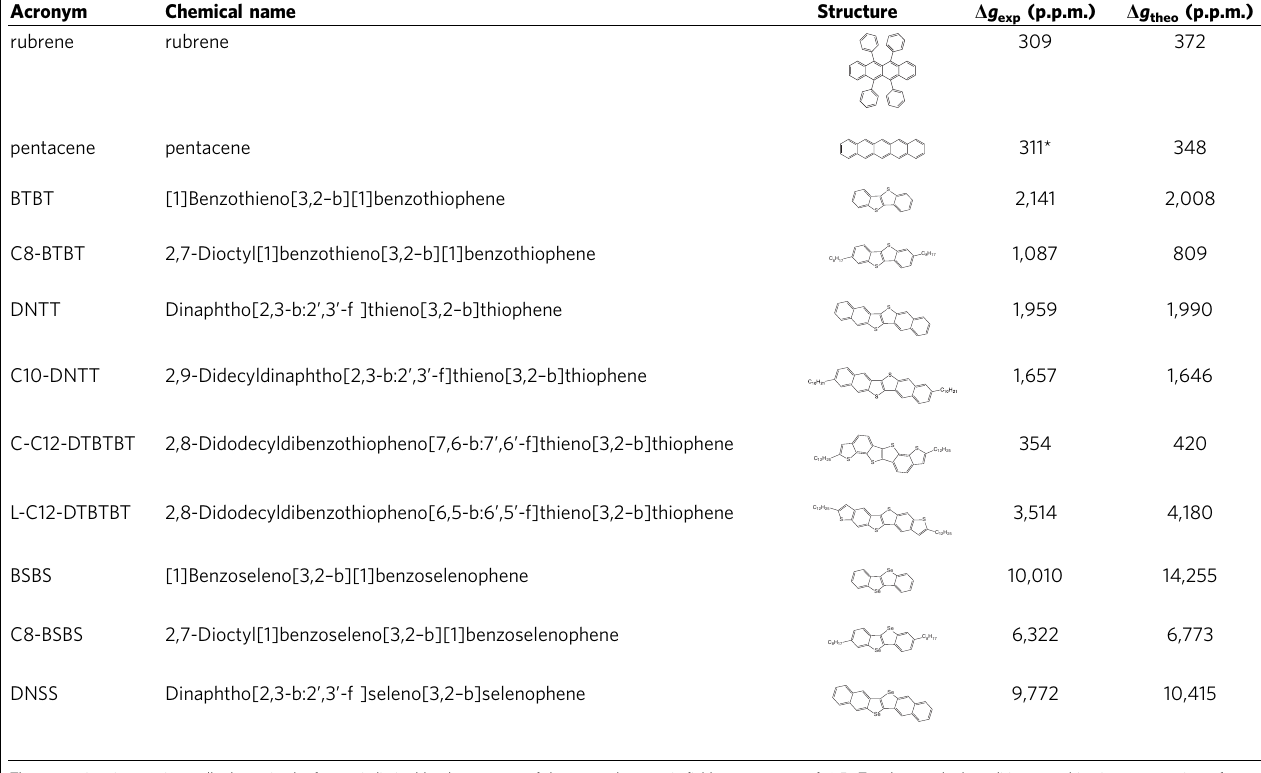
The uncertainty in experimentally determined g -factors is limited by the accuracy of the external magnetic field measurement of ± 5 m Tunder standard conditions, resulting in an uncertainty of ± 30p.p.m. for the g -factors. *Due to the extremely low solubility of Pentacene, the g -shift was measured for TIPS-Pentacene with a very similar conjugated